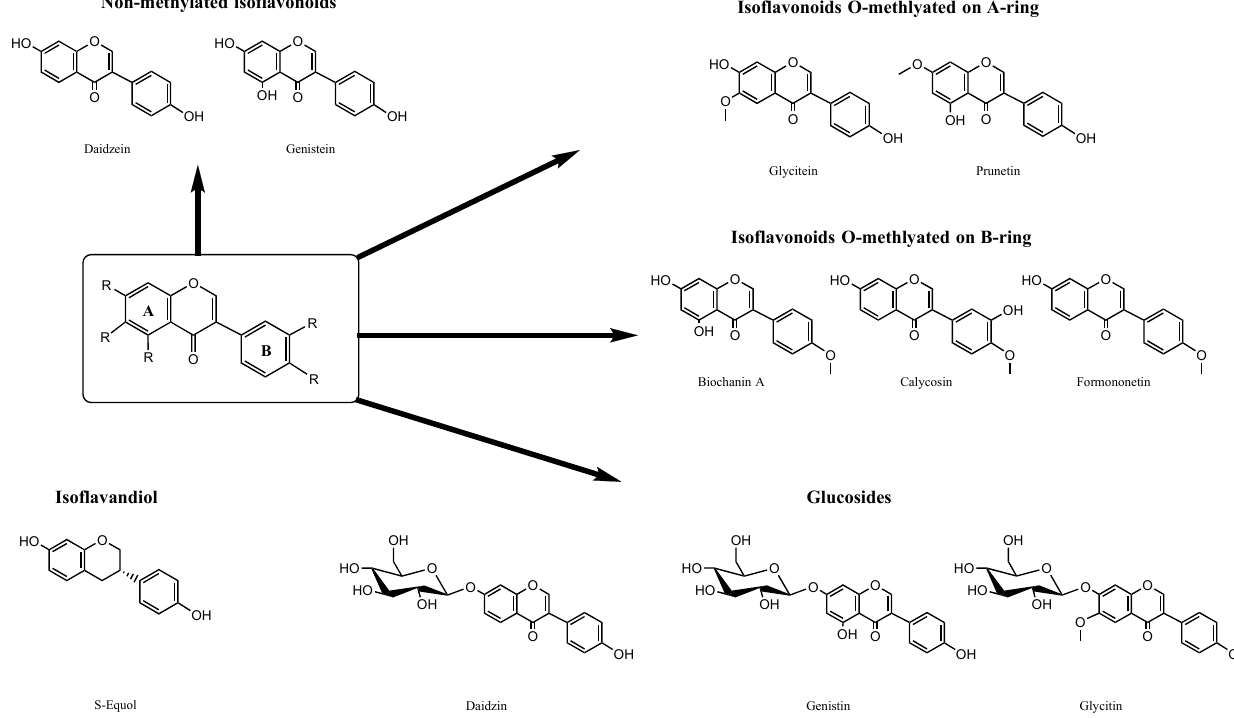
Isoflavonoids O-methlyated on A-ring